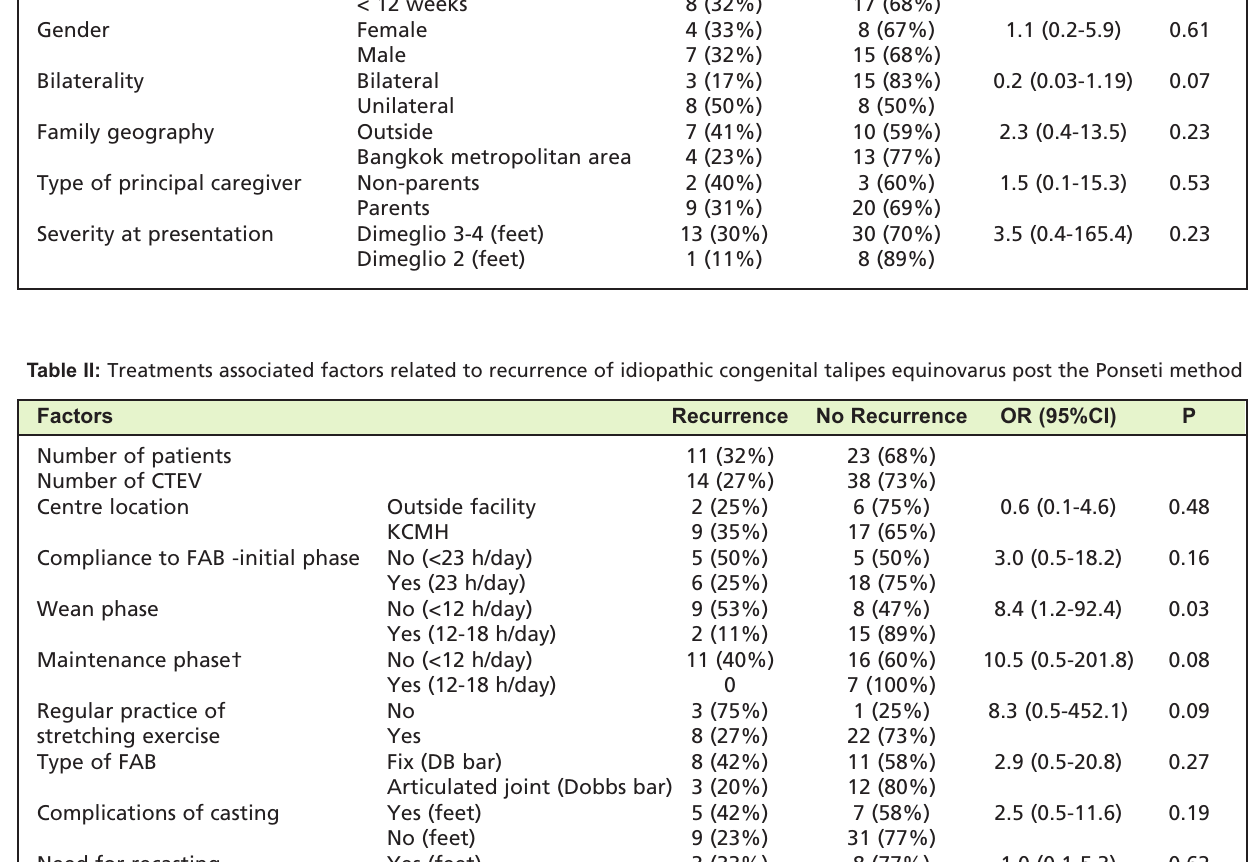
Patients associated factors related to recurrence of idiopathic congenital talipes equinovarus post the Ponseti method Table I: Factors